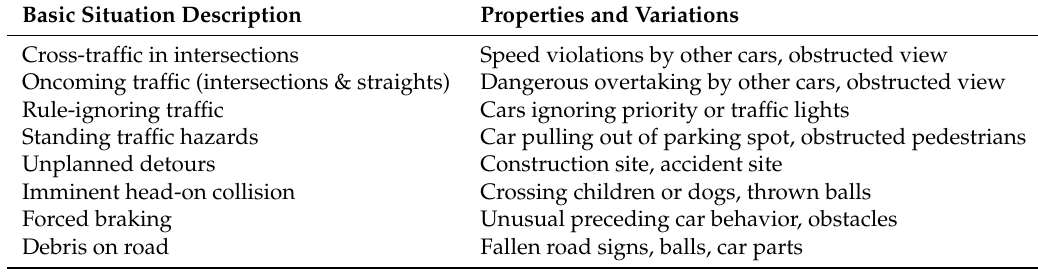
Table 2. The implemented urban driving situations. Some occur multiple times per route in different locations with certain variations as described in the table.